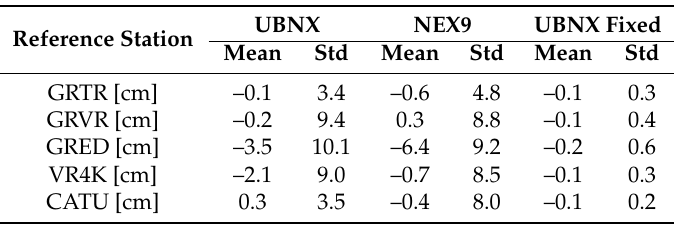
Table 2. Mean and standard deviation (std) of the differences in the vertical direction between the 15-min float baselines of NEX9 and UBNX and their respective 1.5-h